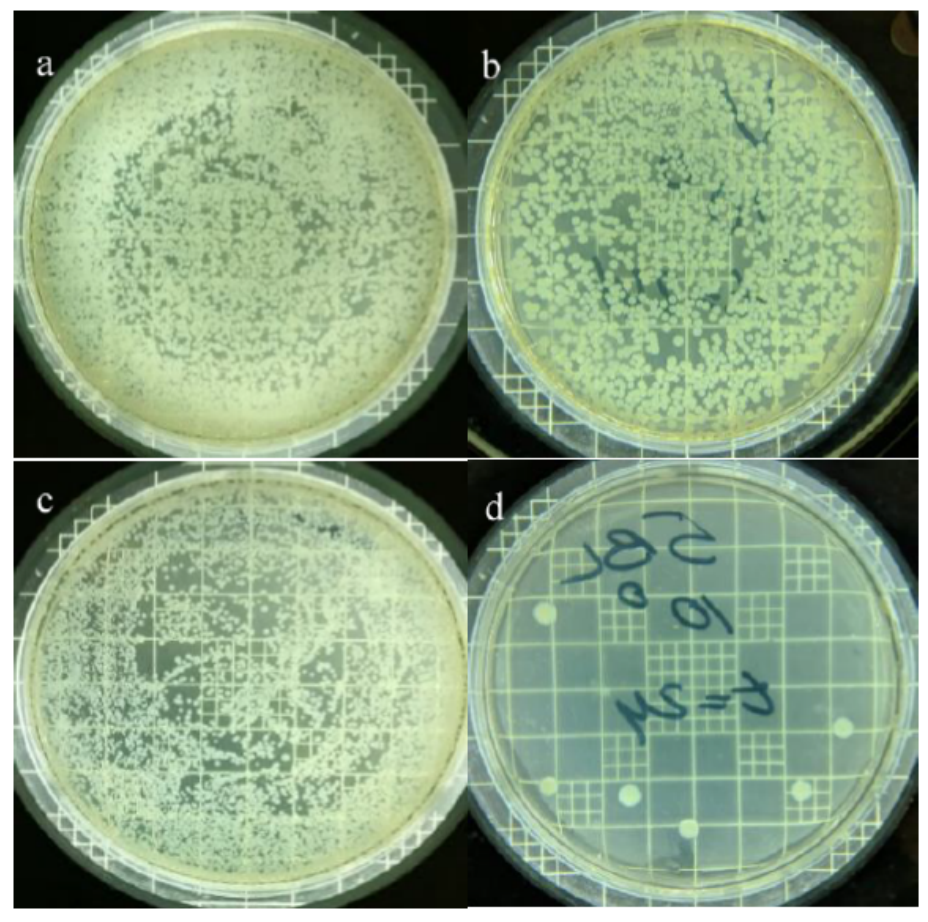
Figure 11. Plate counts ( E. coli ) on a virgin UF membrane at time (t) = 0 h ( a ) and at t = 24 h ( b ); plate Membranes 2020 , 10 , x 13 of 17 counts on 5 AgPNP-BL UF membrane at time = 0 h ( c ) and at time = 24 h ( d ). Figure 1. Experimental schematic diagram and welding location. ( a ) Isometric view of specimen ( b ) Position of fiber laser welding ( c ) Position of TIG welding.